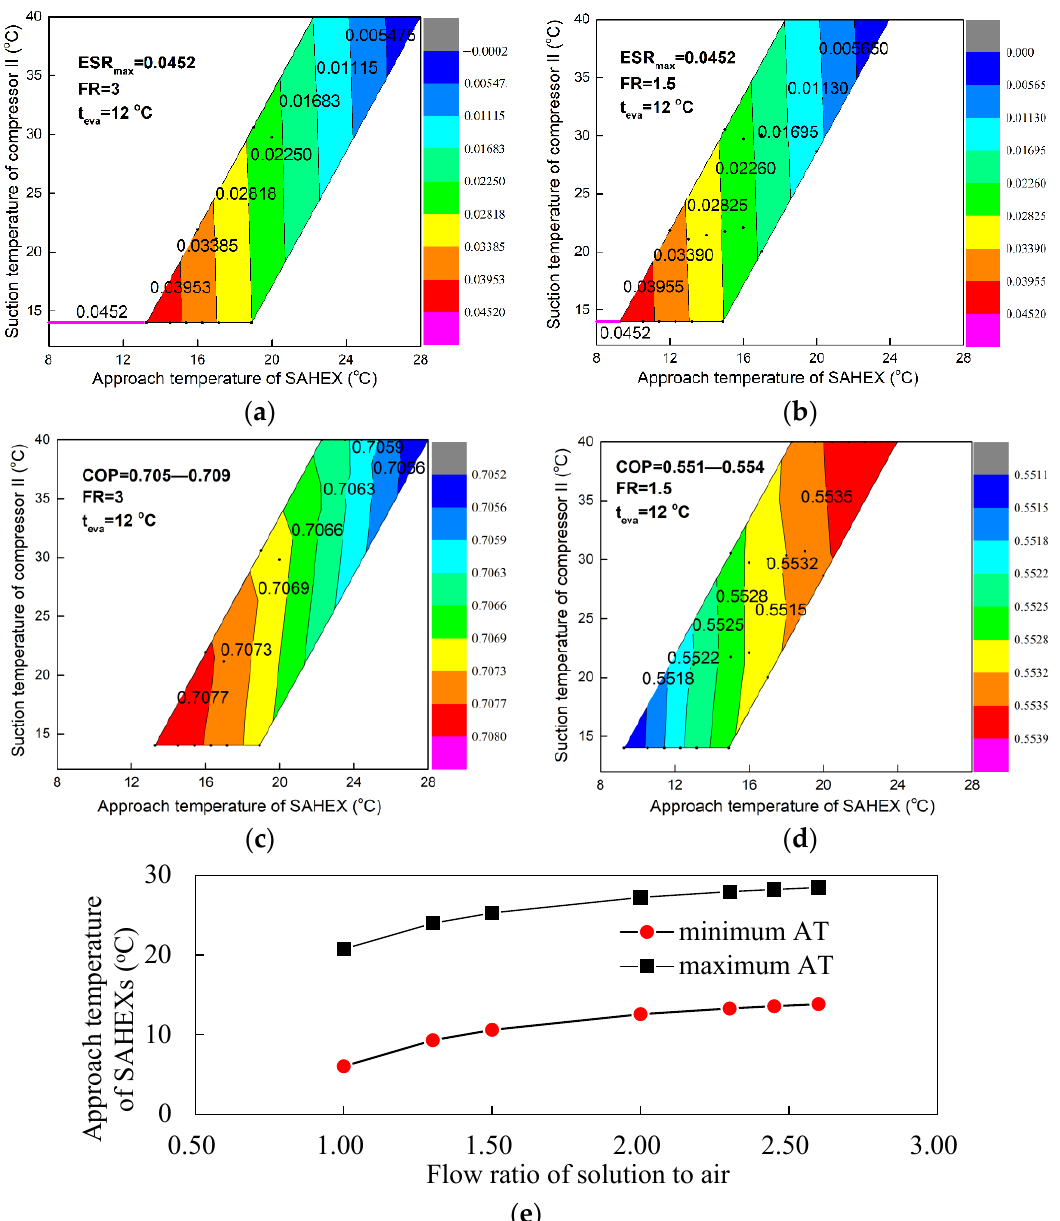
Figure 9. Influence of solution flow ratio on ESR and COP: ( a ) ESR at T eva = 12, FR s-a = 3; ( b ) ESR at T eva = 12, FR s-a = 1.5; ( c ) COP at T eva = 12, FR s-a = 3; ( d ) COP at T eva = 12, FR s-a = 1.5; ( e ) minimum and maximum AT sahex at different FR s-a